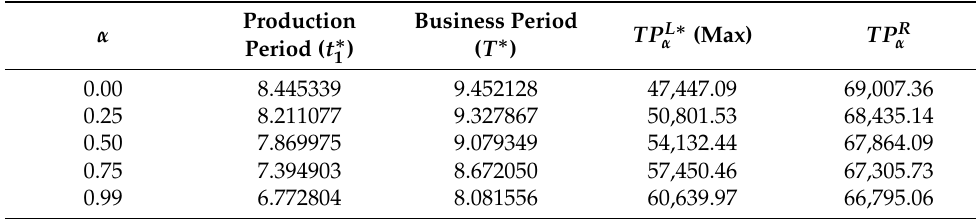
Table 5. Optimum results of Example 2 for maximizing TP L α .